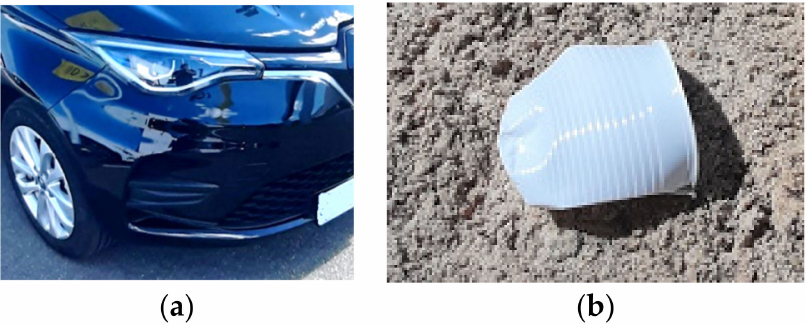
Figure 1. ( a ) High-quality and long-life automotive plastics, improving vehicle performance and reducing weight, fuel consumption, and emissions; ( b ) low-quality and short-life non-sustainable utilization of disposable